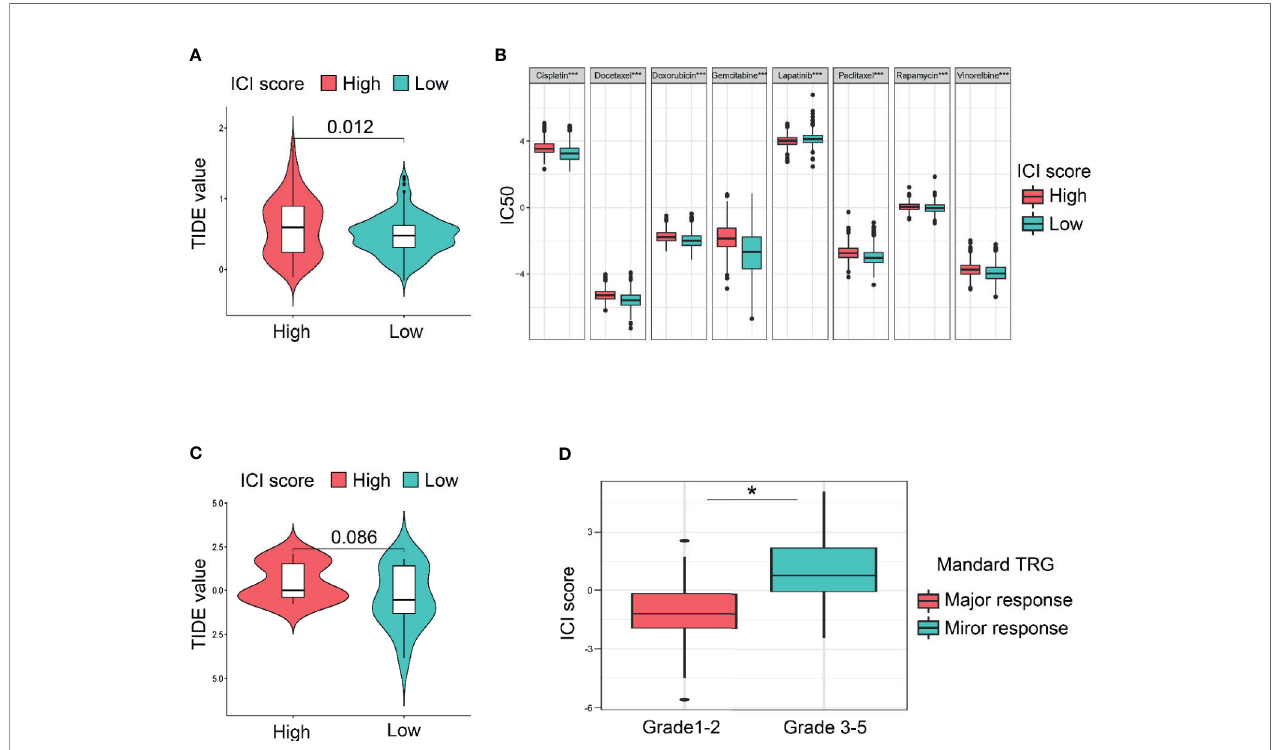
FIGURE 6 | Drug sensitivities prediction using the ICI score classi fi cation system based on different cohorts. (A) The lower ICI score group presented with lower TIDE score compared with the higher ICI score group, indicating that the lower ICI score group is more sensitive to the immune check point therapy in TCGA Cohort. (B) The IC50 for GC-concerning chemotherapeutics were compared between low and high ICI score groups. Most of the IC50 was lower in low ICI score group except for lapatinib in Integral Cohort. (Kruskal-Wallis test. ***p < 0.001; ns, not signi fi cantly different). (C) As for the Zhongshan Cohort, the TIDE value was not signi fi cantly different despite a tendency of decreasing in low ICI score group. (D) A lower ICI score was also observed in patients diagnose as major response after neoadjuvant chemotherapy, con fi rming the value of ICI score for chemotherapy response prediction in Zhongshan Cohort. (Kruskal-Wallis test. *p <